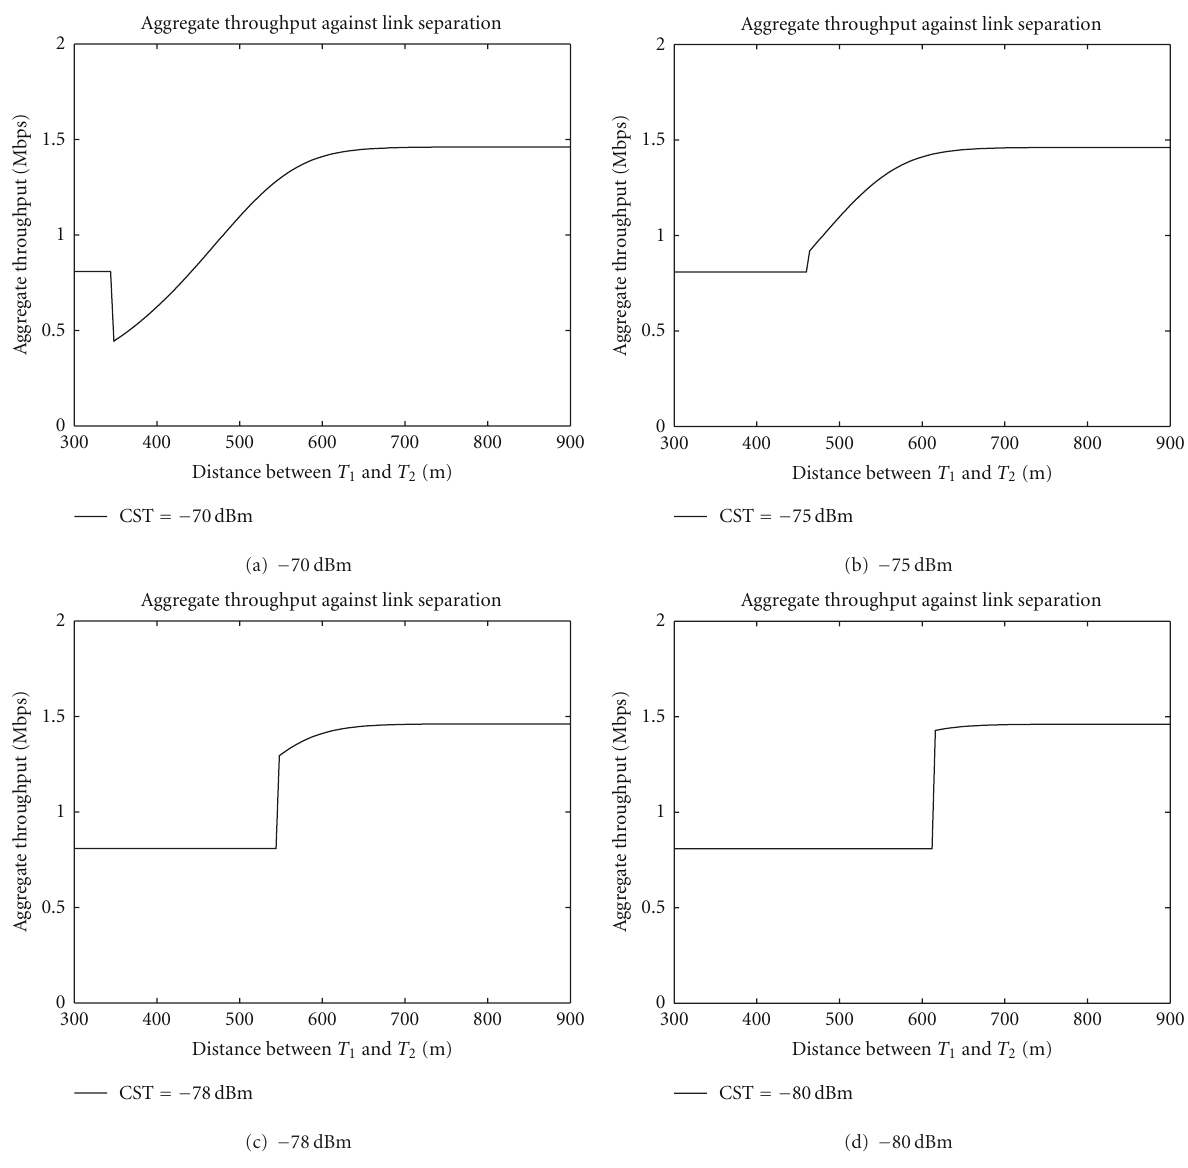
Figure 7: Aggregate throughput for the topology in Figure 5 with length of links = 400 meters and various carrier sensing thresholds.